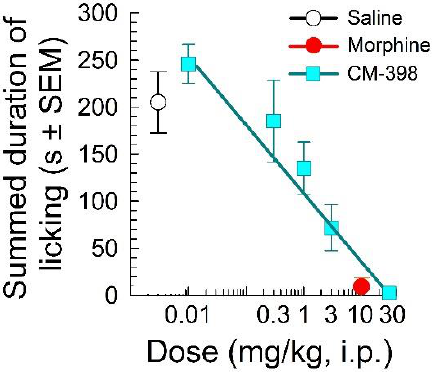
Figure 3. Evaluation of CM-398 for antinociceptive effects in the mouse formalin-induced inflammation assay. Dose-dependent antinociception of sigma-2 receptor ligand CM-398 followed i.p. administration. Control mice were treated with saline (0.9%, i.p.) or morphine (10 mg/kg, i.p.). All points represent summed time spent licking ± SEM administered to 5 – 10 mice for all points.